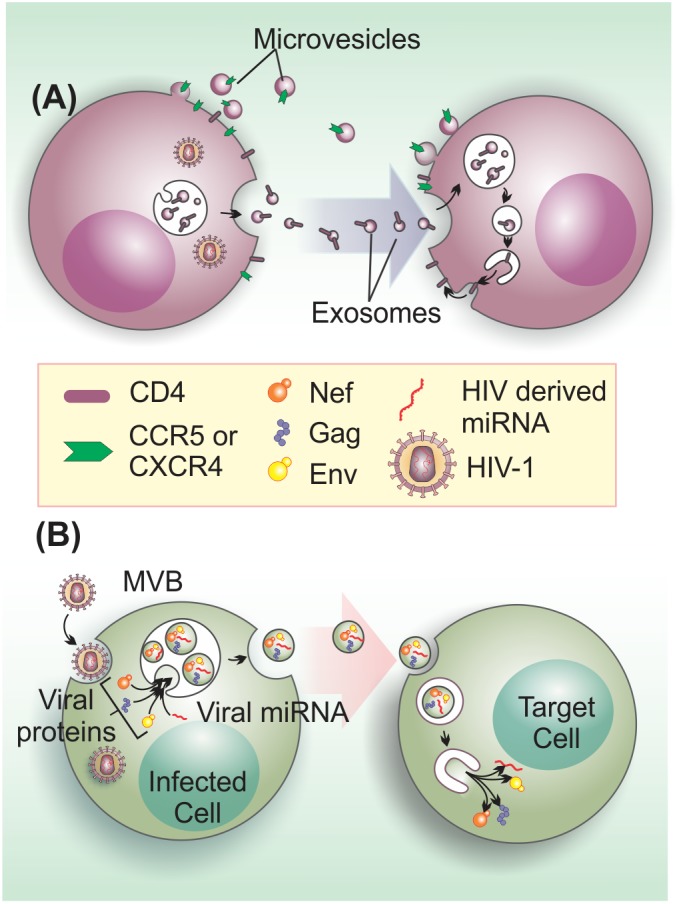
Extracellular vesicles on the enhancement of HIV-1 infection and pathogenesis. (A) EVs from HIV-1 infected cells transfer HIV-1 receptors to null cells to spread infection. EVs transfer the HIV-1 co-receptors CXCR4 and CCR5 and may be also involved in CD4 transfer (Mack et al., 2000; Esser et al., 2001; Rozmyslowicz et al., 2003). (B) HIV-1 components, such as viral proteins (Gag, Env, and Nef) and microRNAs may be transferred to target cells to enhance infection through the activation of quiescent CD4+ T cells (Arenaccio et al., 2014), apoptosis induction in bystander CD4+ T cells (Lenassi et al., 2010), or other unknown effects.